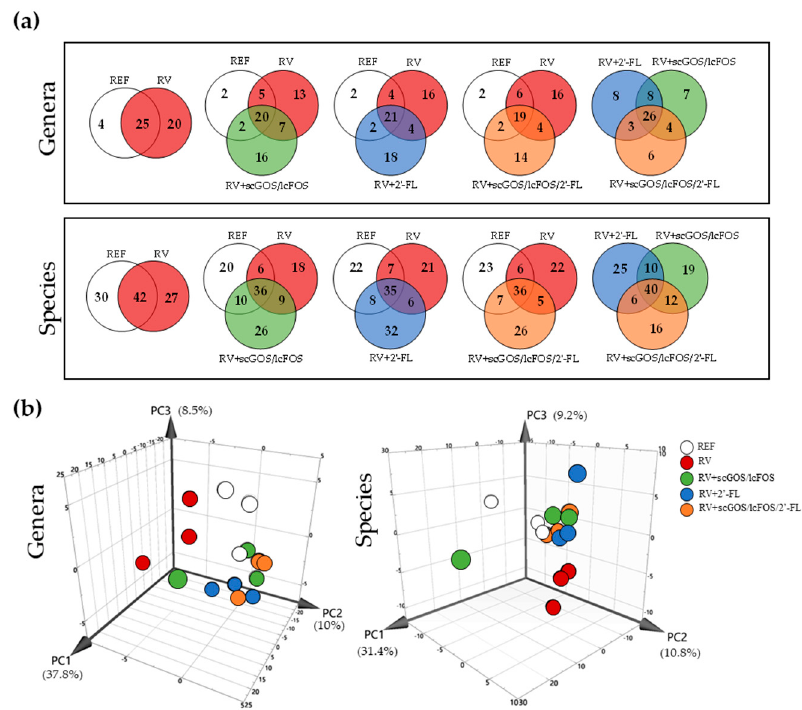
Figure 5. Analysis of the fecal microbiota diversity in genera and species at the peak of diarrhea (day 8): ( a ) Representation of Venn diagrams and ( b ) Principal Components Analysis (PCA) of all genera and species. To estimate the presence or the absence of these taxa in the experimental groups, it was agreed that all groups displaying 2 or 3 animals (out of the 3 analyzed in each group) with a bacterial proportion were computed as present, while the groups displaying 1 animal or none were computed as absent. The results are derived from n = 3 /